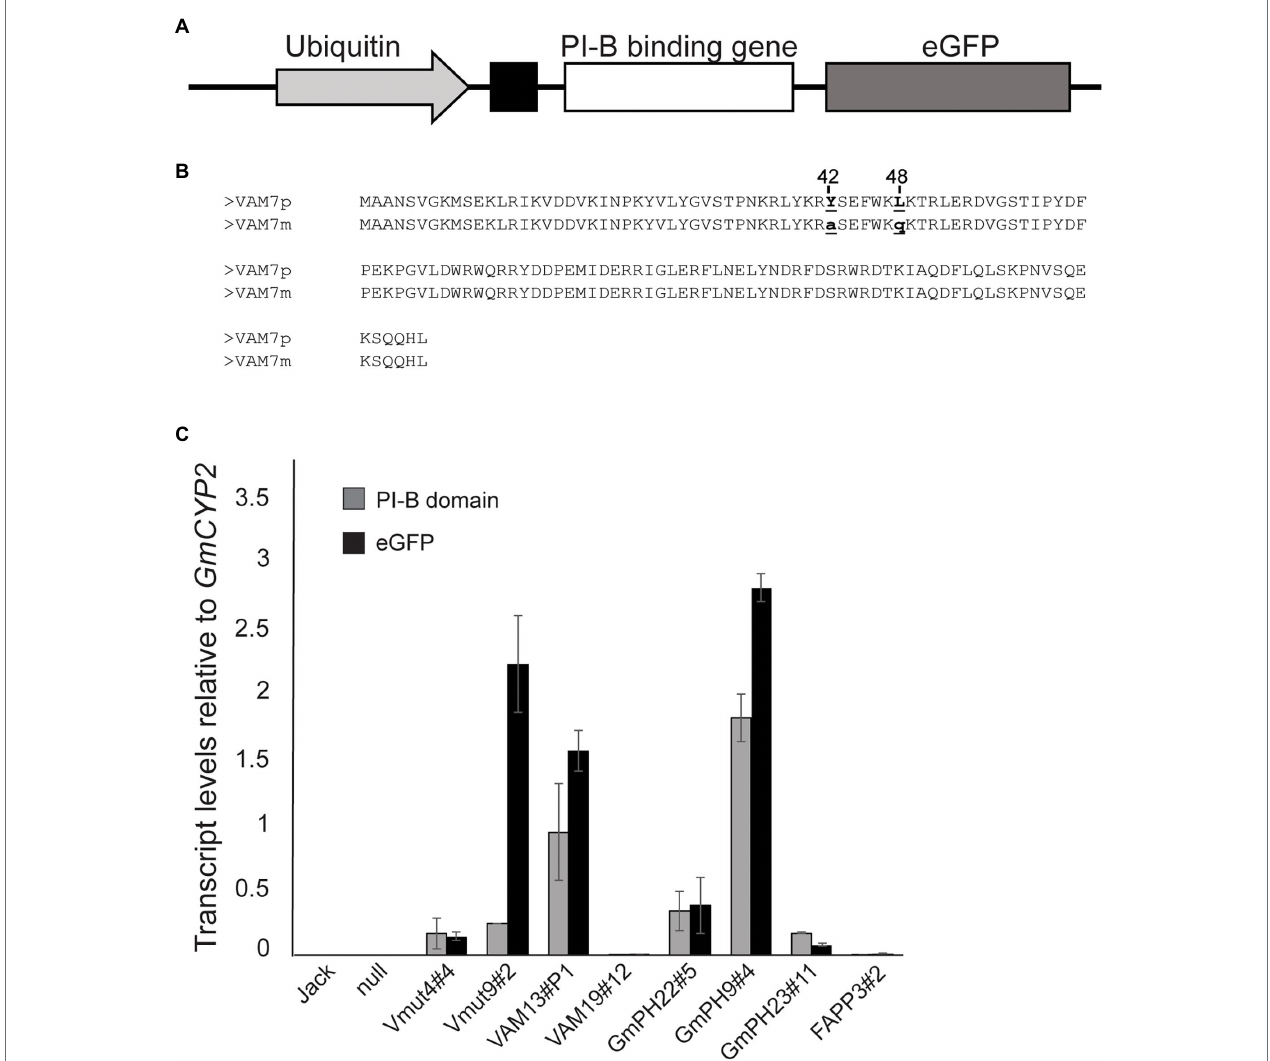
FIGURE 1 | Structure and expression of transgenes encoding phosphoinositide-binding proteins. (A) Illustration of transgene showing the phosphoinositide- binding protein gene fused to the eGFP reporter gene, downstream of a PR1a secretory leader. The transgene is placed under control of the soybean Ubiquitin 3 promoter. (B) Amino acid sequence alignment of the VAM7 PX domain compared to the non-PI3P-binding VAM7 mutant (Vmut). Amino acid substitutions from VAM7 to Vmut include tyrosine to alanine at position 42, and leucine to glutamine at position 48. (C) Transcript levels of transgenes across independent soybean lines, measured by quantitative reverse transcriptase PCR. Primer pairs specific for each PI-binding (PI-B) domain (e.g., VAM7, GmPH) and for the eGFP reporter domain were used in each case ( Supplementary Table 6 ). Transcript levels are relative to the internal control gene GmCYP2 . Bars are average of values from the trifoliates of three different plants, each trifoliate run in duplicate. Error bars show the